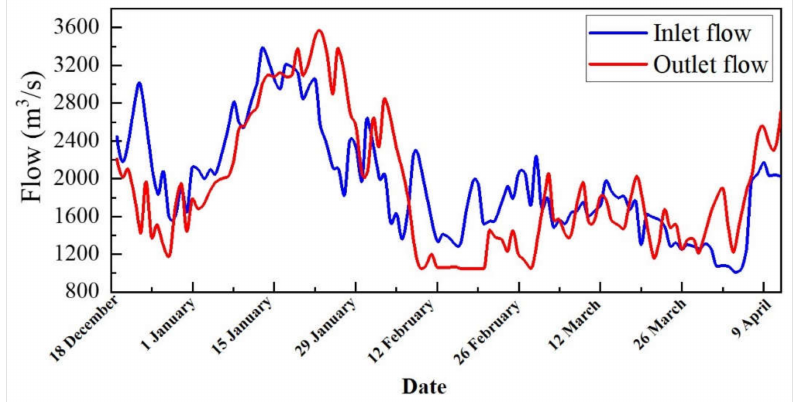
Figure 11. Changes in the inlet and outlet flow during the water storage